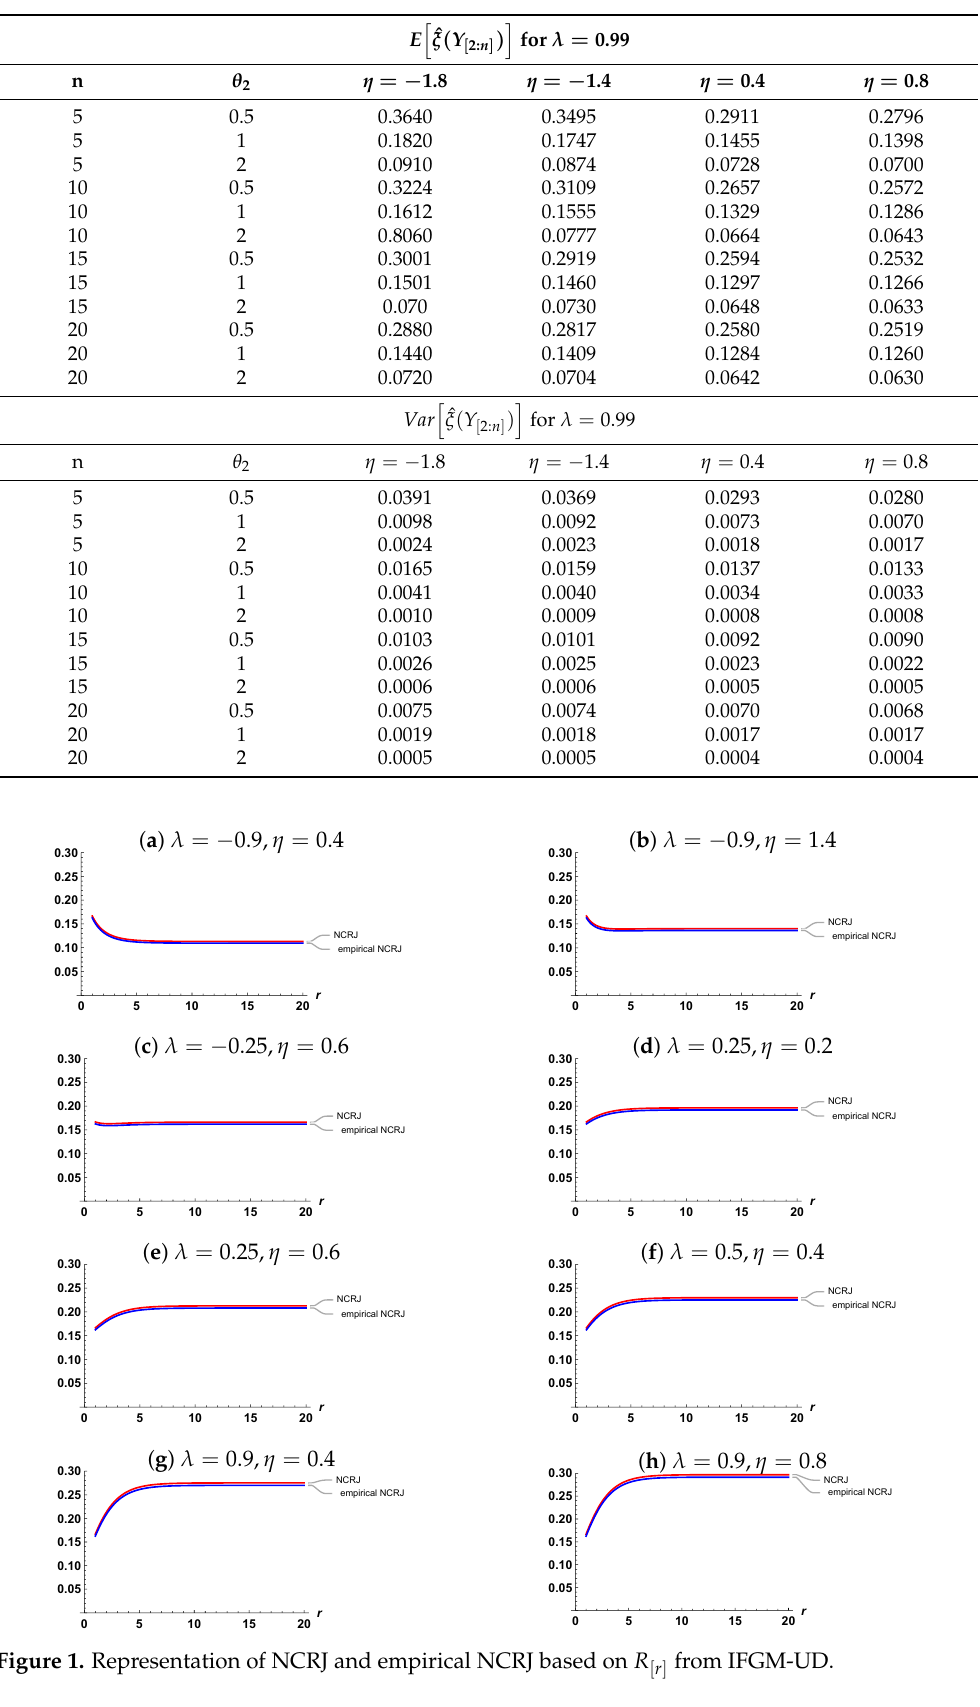
(cid:104) (cid:105) ˆ ξ ( Y ) and Var [ 2: n ]